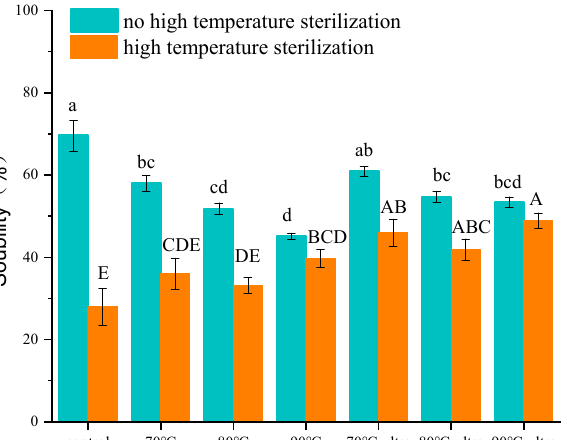
Figure 1. Solubility of different coconut globulin samples (ultra: 53 kHz, 40 w / l ; 70, 80 and 90 °C represent preheating for 20 min; high ‐ temperature sterilization: 135 °C for 60 s). Different letters indicate significant differences at p < 0.05.